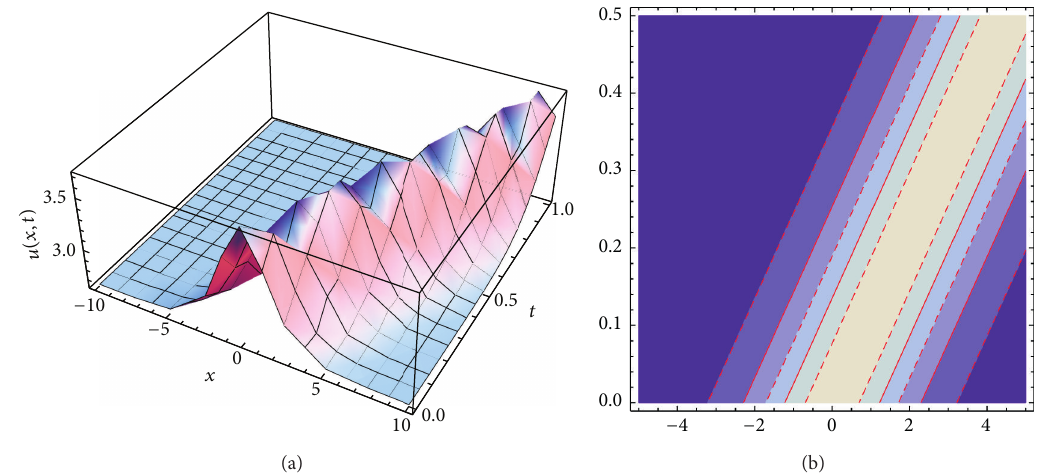
Figure 4: (a) Travelling waves solutions of (35) is plotted: stability bright solitary waves. (b) Travelling waves solutions of (35) is plotted: stability contour of solitary